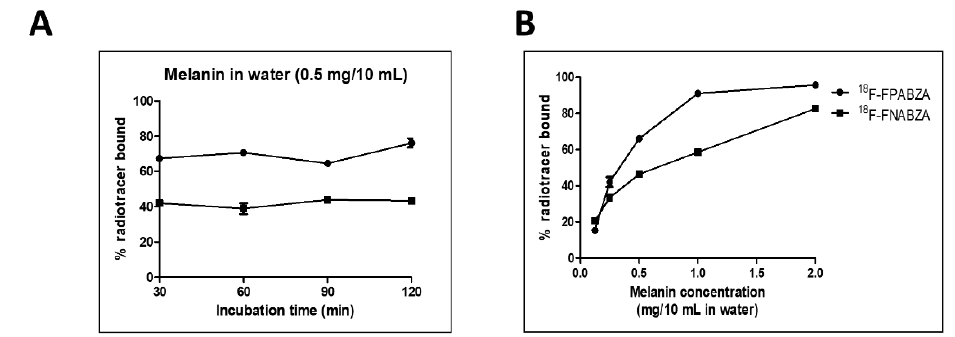
Figure 3. In vitro stability of 18 F-FPABZA in PBS and fetal bovine serum (FBS).